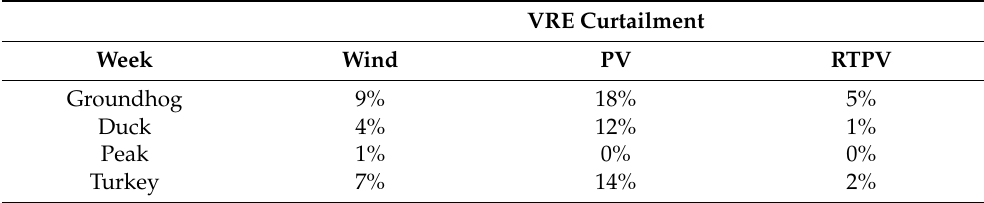
Table 8. VRE curtailments expressed as a percentage of total weekly VRE production for each of the weeks analyzed for the base case with no